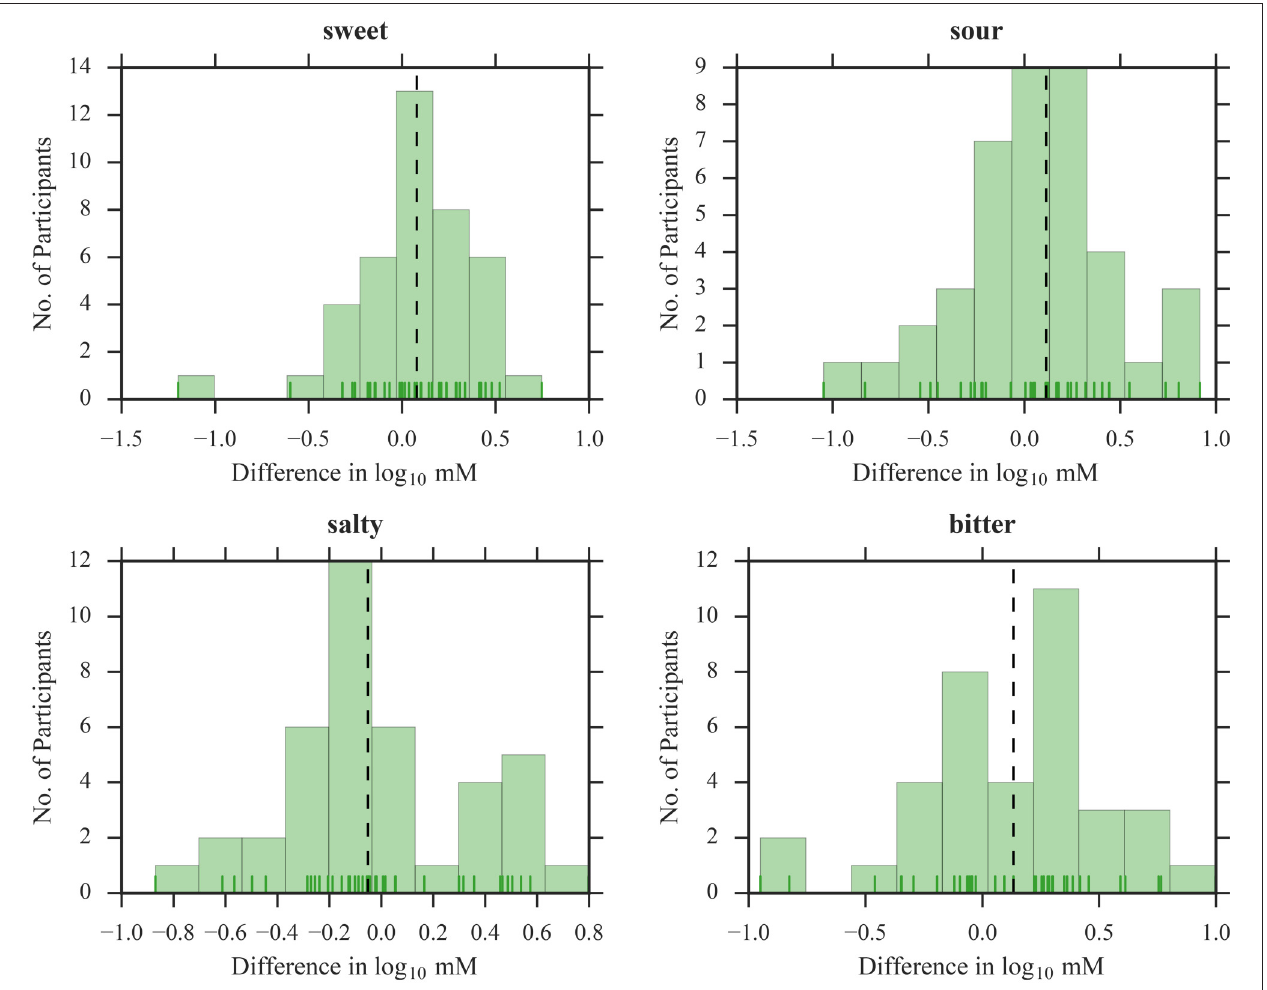
FIGURE 6 | Distribution of threshold differences between test and retest for QUEST. Green vertical lines depict individual participants; black dashed lines represent the